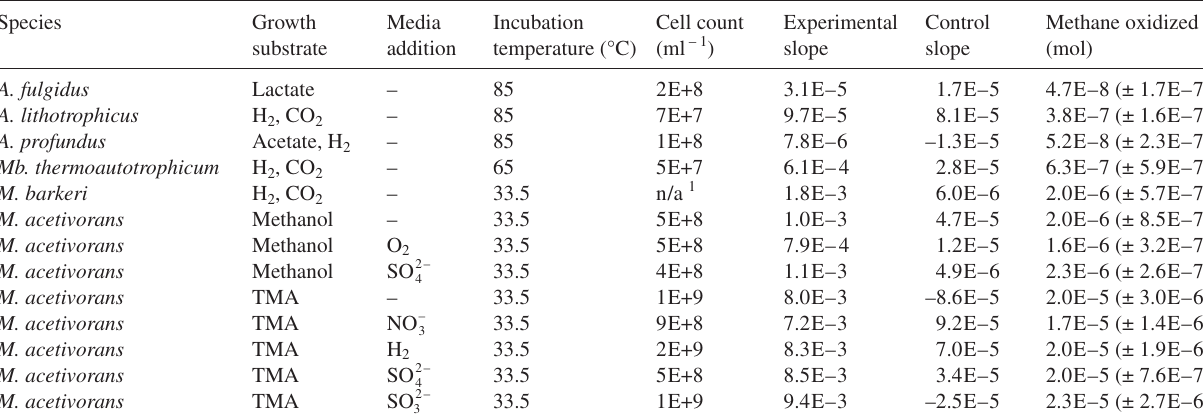
Table 1. Growth conditions and methane oxidation per culture experiment. Each culture was initially provided 1.79E–3 mol of methane. In addi- tion, based on methanogenesis, stoichiometry and measurements performed in parallel experiments, the cultures produced 1.3E–3, 2.8E–3 and 5.5E–3 mol of methane for the cultures grown on H 2 /CO 2 , methanol and trimethylamine (TMA),